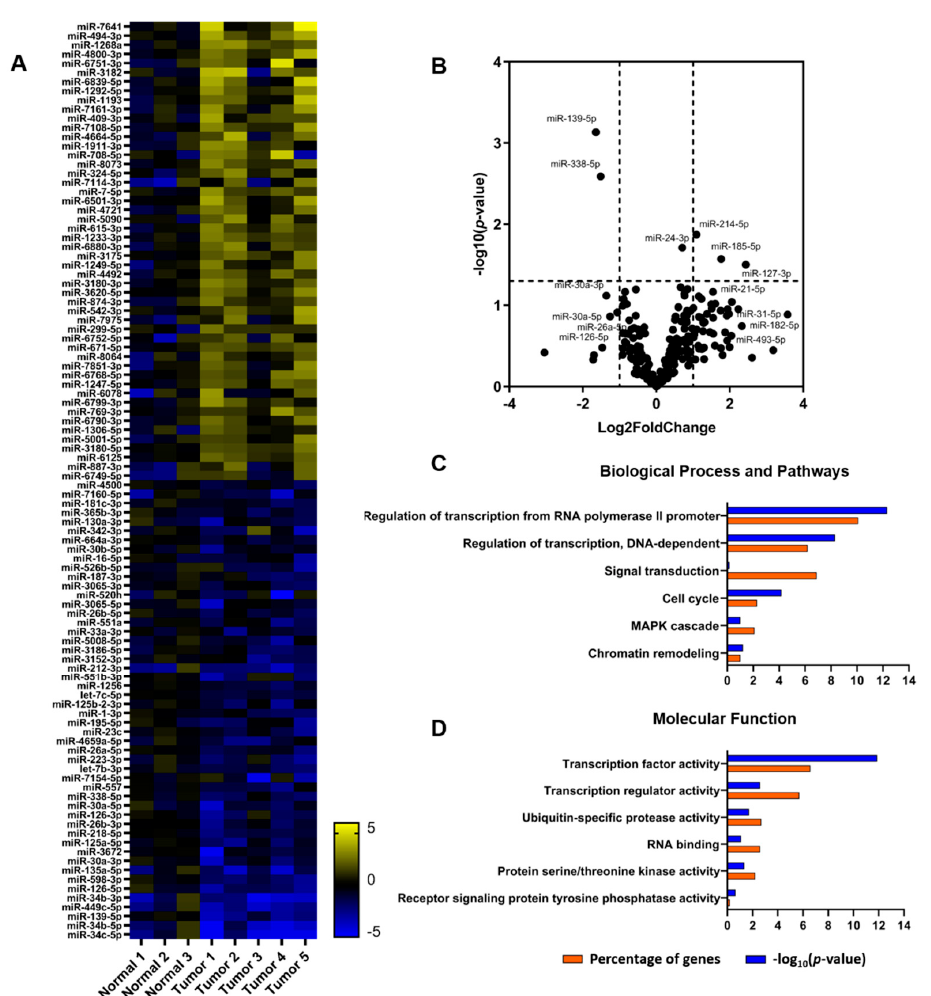
Figure 1. Expression profile of miRNAs in lung cancer. ( A ) Heatmap of the 100 most altered miRNAs in NSCLC. The analysis was performed in 3 normal and 5 tumor tissue specimens (Patient information is described in Table S1). The heatmap was constructed based on the log2 fold change values and normal samples are shown after normalization of individual samples versus the mean of RPM. Yellow and blue colors indicate up- and down- regulation, respectively. ( B ) Volcano plot of all miRNAs assessed in the present analysis. The volcano plot displays the relationship between fold change and significance using a scatter plot view. A higher value indicates greater significance in the y-axis and the x-axis illustrates the difference in expression levels of miRNAs. ( C , D ) GO enrichment analysis on the predicted targets of the statistically significant altered miRNAs. Top pathways in “Biological Process and Pathways” and “Molecular Function” are shown as percentage of genes (orange) and p -value (blue), respectively. Previous studies featured a key-role for tRFs in cancer onset and progression, either as tumor promoters or tumor suppressors (reviewed in [38]). Although distinct signatures of tRFs are evident across several cancer types and vary in number, only few specific tRFs have been shown to modulate the expression of genes linked to tumorigenesis. Activation of oncogenes like MYC has been shown to modulate the expression profiles of tRFs in human lymphocytes, an observation that links translation deregulation, tRNA transcription and tRF production with early tumorigenesis [17]. After isolation of the <200 nt RNA fraction, we separated the tRNA containing fraction from the smaller RNAs (<40 nt) onto a 12% UREA-PAGE and after gel excision, libraries corresponding to each RNA pool were produced for further NGS analysis. Several available tRF databases (reviewed in [5]) are available and provide different features for bioinformatics analyses. For our analysis we used the tRF